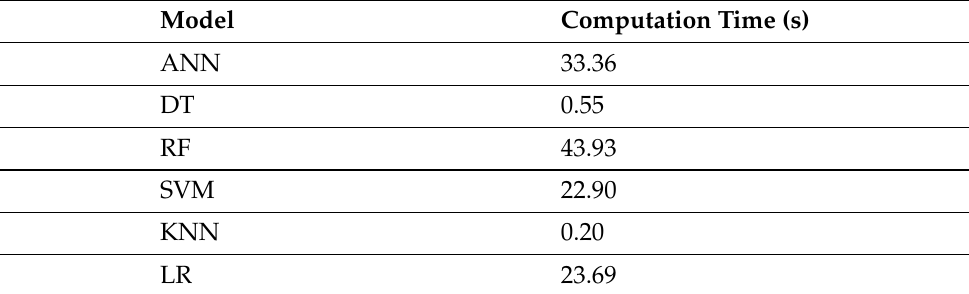
Table 9. Computational time for